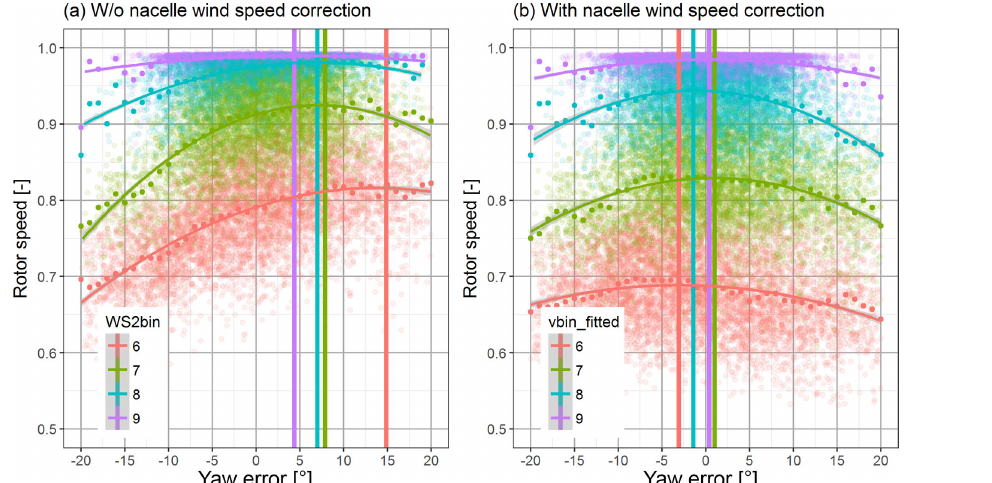
Figure 14. Best turbine alignment based on nacelle wind speed without the proposed linear flow correction of nacelle instruments (a) and with the proposed correction (b) . The plot description is similar to Fig. 11. The only difference is the wind speed used for data